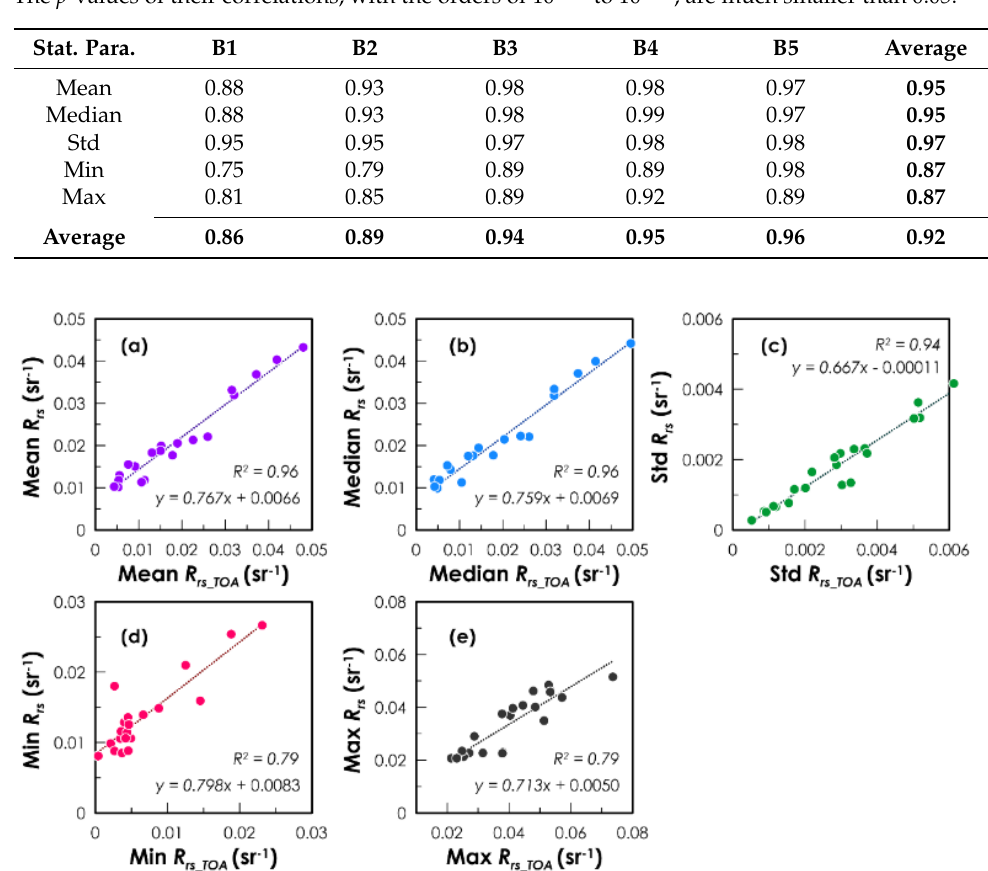
Figure 4. Relationships between the statistical parameters (( a ) mean, ( b ) median, ( c ) std, ( d ) min, and ( e ) max) of unnormalized R rs and R rs_TOA for the 24 water bodies at the B3 band (555 nm) of Landsat-8. Table 1. Correlation coe ffi cients between the statistical parameters of unnormalized R rs and R rs_TOA for the 24 water bodies at fi ve Landsat-8 bands and the averages for all fi ve bands and fi ve parame- ters. The p -values of their correlations, with the orders of 10 − 12 to 10 − 14 , are much smaller than 0.05. Stat. para.